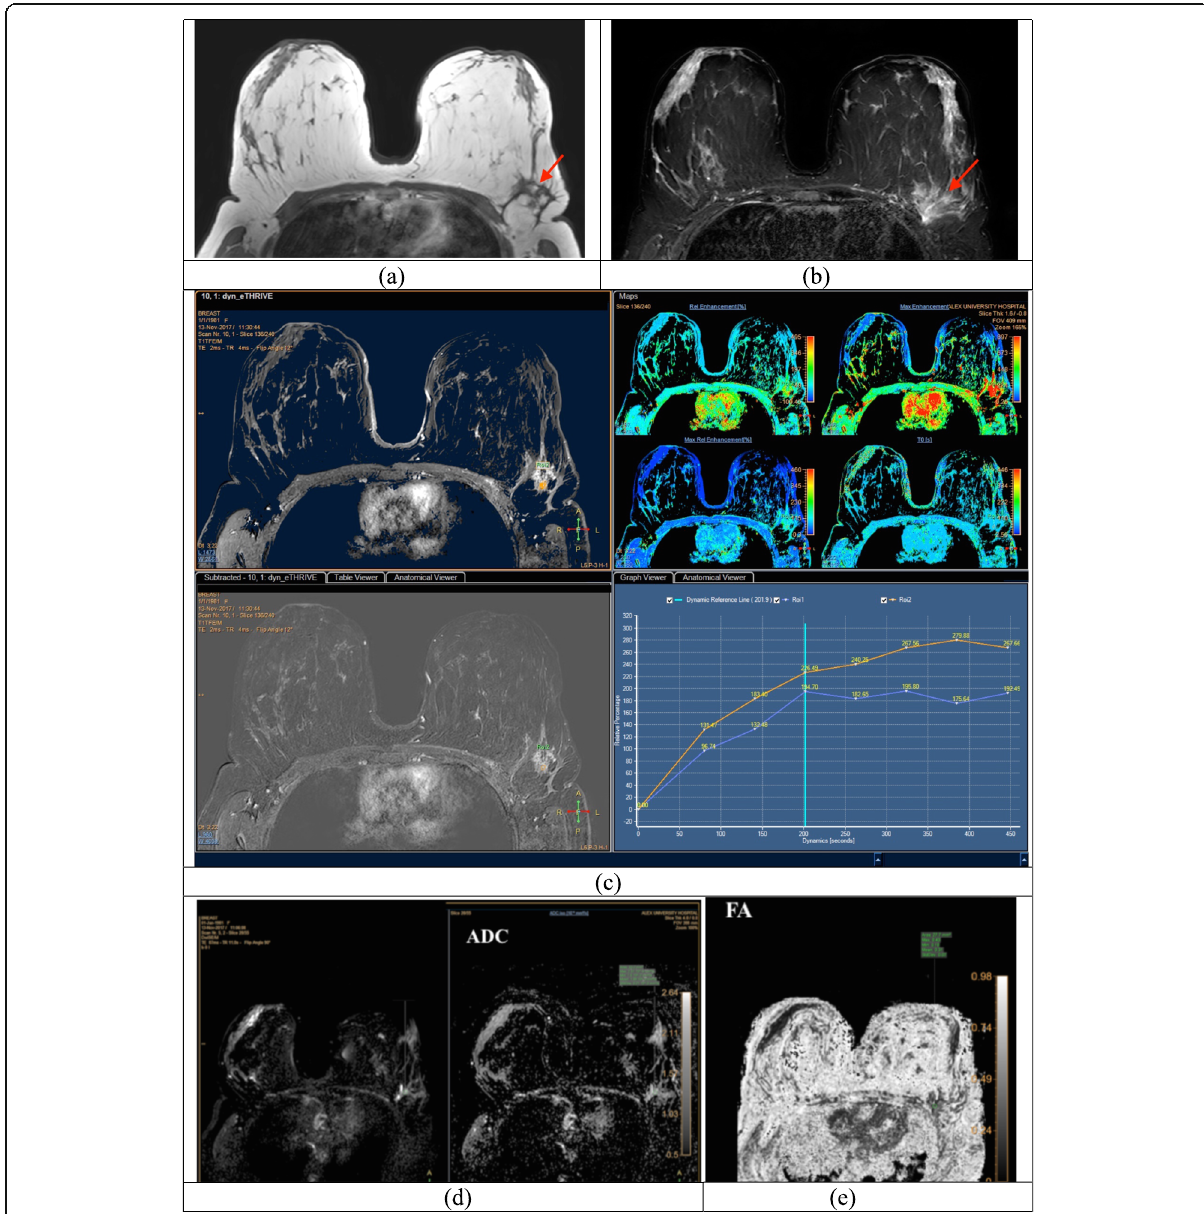
Fig. 2 40-year-old female with history of left breast cancer managed by lumpectomy on follow-up mammogram and ultrasound revealed irregular lesion seen at lumpectomy site (BIRADS 4a). CE-MRI breast ( a , b ) axial T1 and axial STIR showed irregular isointense lesion with central fat signal (red arrow). c Dynamic THRIVE images showed enhancing irregular lesion with suppressed central areas of fat (red arrow), showing type I curve of dynamic enhancement. d DWI showed no restricted diffusion (ADC = 1.9 × 10 − 3 mm 2 /s). e FA map, FA = 0.18 (< 0.2) matching with the benignity of the lesion. Final MRI diagnosis was fat necrosis at site of lumpectomy (BIRADS 3), which was confirmed later by clinical and imaging